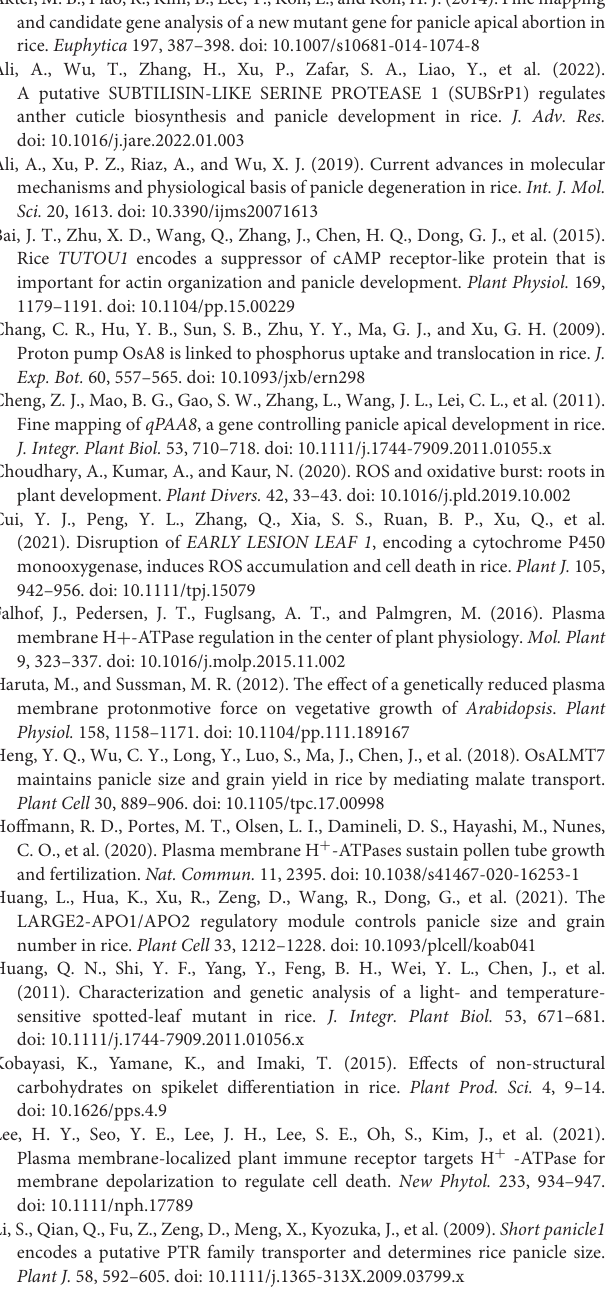
days at seeding stage, CK (A) , 75mM (B) , 150mM (C) . (D–F) Phenotype of WT and lmpa mutant after recovery for 7 days. (G) Survival rate of rice seedlings after recovery for 7 days. Error bars represent standard deviation (SD) ( n = 3); ∗∗ Significant difference at p < 0.01 compared with the WT by Student’s t -test. Supplementary Table 1 | Primers used in this study. Supplementary Table 2 | List of genes in the 122.6-kb target